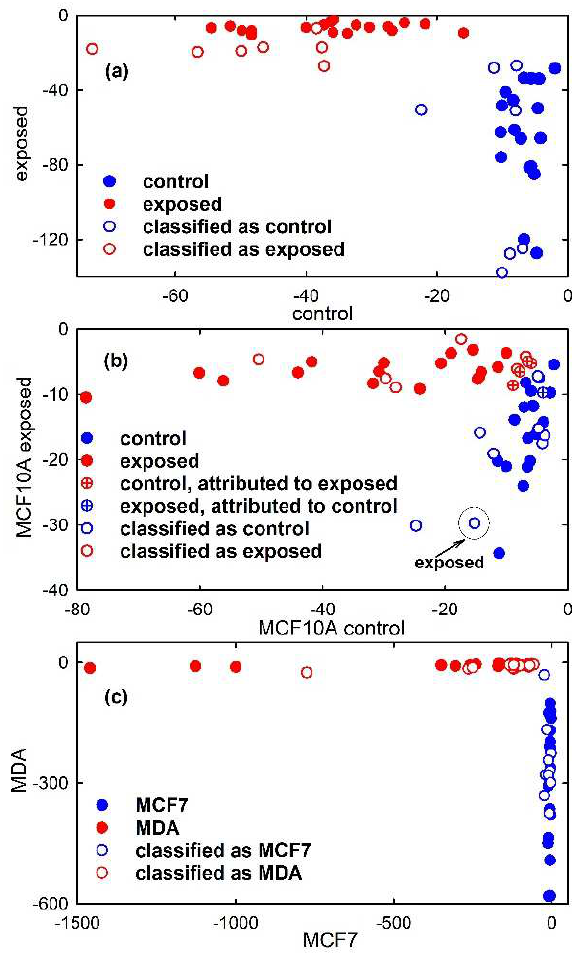
Figure 7. Discrimination plot obtained from the results of Linear Discriminant Analysis model developed using 7 principal components from Principal Component Analysis. The scatter plot shows the discrimination of synthetic control-like spectra (filled blue circles) and exposed-like vibrational spectra (filled red circles) in ( a ), that of Raman spectra of control (filled blue circles) and exposed (filled red circles) MCF10A cells in ( b ) and that of FTIR spectra of MCF7 (filled blue circles) and MDA (filled red circles) cells in ( c ). Crossed circles in ( b ) are related to samples of the calibration set which are erroneously attributed to the PCA-LDA model. The projections of the test samples on the PCA-LDA model are shown as hollow circles. One misclassified sample of the test set is enclosed inside a circle and labelled in ( b ).